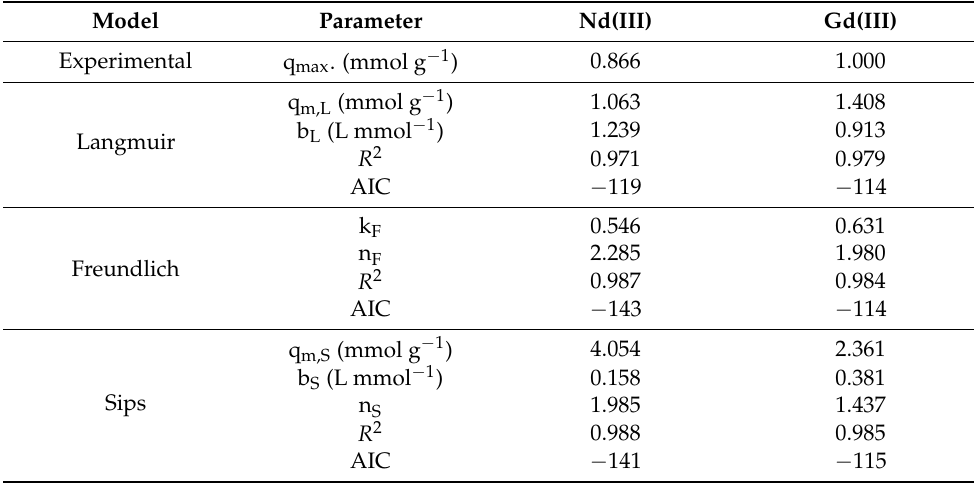
Table 2. Nd(III) and Gd(III) sorption isotherms—parameters for